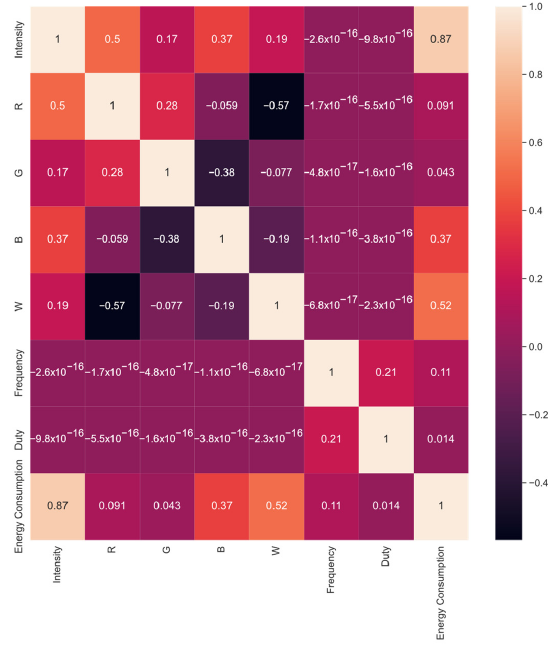
Figure 4. Pearson correlation heat map results.